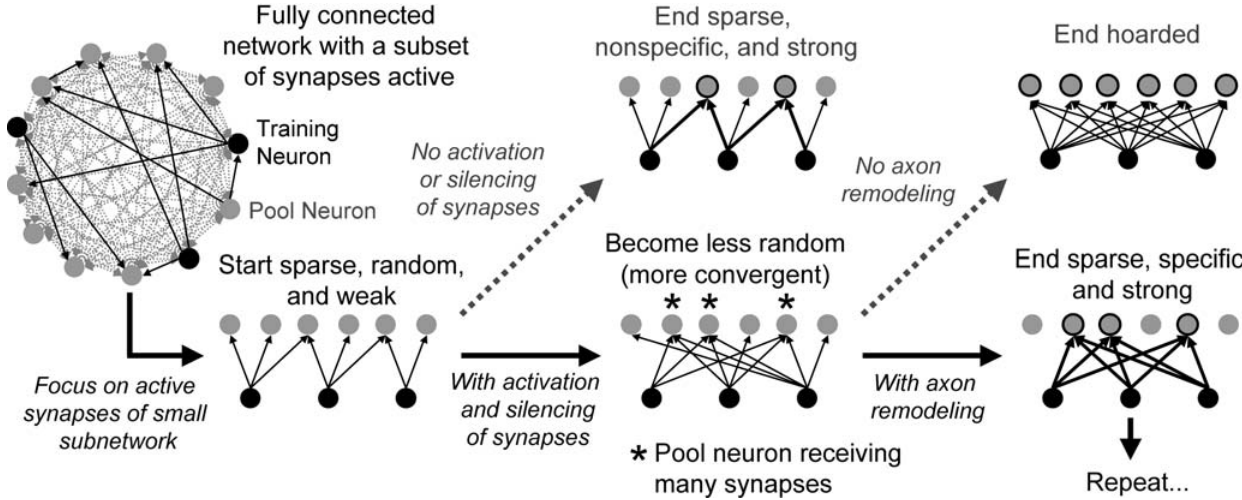
Figure 2. Cartoon of the formation model. The network is fully connected, but 90% of connections are silent synapses (gray dashed arrows). The active connections (black solid arrows) are randomly set. Black ovals are training neurons (TN), which receive external excitation at the start of each trial, and gray ovals are pool neurons (PN), which spike spontaneously. Following the bent black arrow shows a small subnetwork that includes only the TN and their active synapses and postsynaptic PN. Since the active network is sparse and random, TN do not converge upon the same set of PN except for a random few. Without the ability to turn on silent synapses (follow the gray dashed arrow to the upper middle subnetwork), STDP can act only over the active synapses. Therefore, only the few neurons receiving convergent synaptic input from the TN can spike consistently after the TN. If, however, silent synapses can activate due to spike activity (follow black solid arrow to the lower middle subnetwork), then the TN can activate synapses onto the same set of PN. Since these neurons receive more excitation and hence are more likely to spike, the synapses from the TN to these neurons are more likely to potentiate. This is a positive feedback. These synapses will pass the supersynaptic threshold (follow black solid arrow to the lower right subnetwork), and the TN will coordinate to make convergent synaptic connections onto the same set of PN. The TN do not connect to other neurons due to axon remodeling, in which weak connections from a neuron are pruned once a finite number of super-connections from the same neuron are formed. Without axon remodeling (follow gray dashed arrow to the upper right subnetwork), the TN can continue to activate synapses onto all PN and hoard the entire network to themselves, meaning that all neurons in the network will be induced to spike after they do.